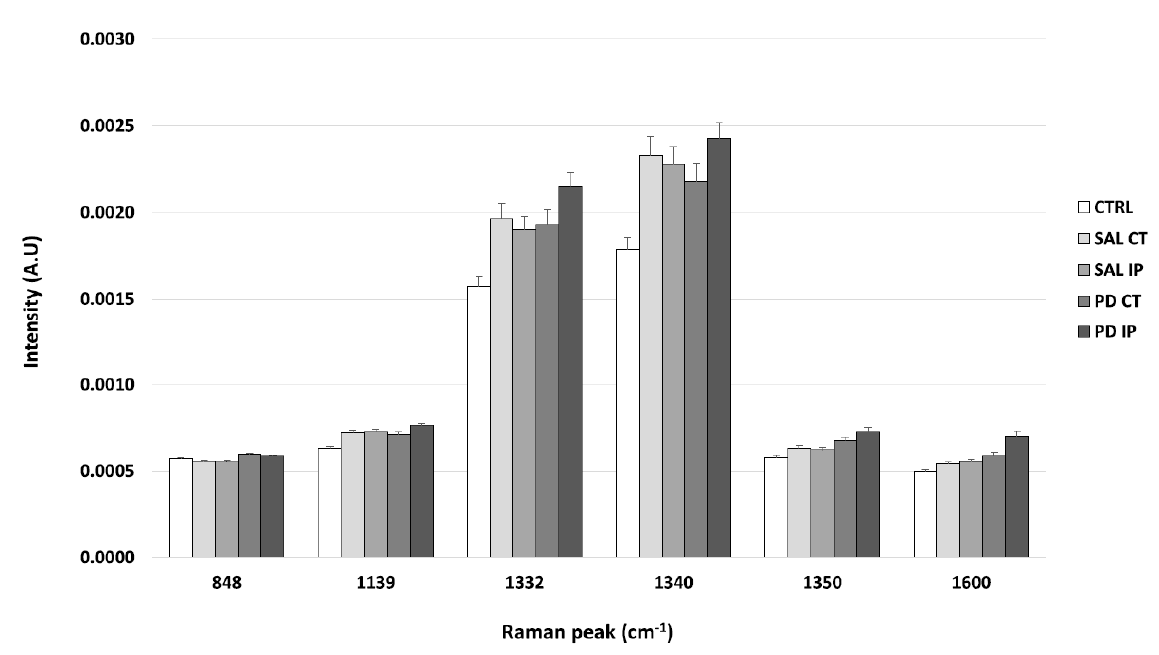
Figure 7. The intensity of the Raman peaks assigned to the DNP in the literature was calculated from the collected Raman spectra from all of the conditions. Mean intensities ± SEM from each condition are presented for the DNP-labeled samples.